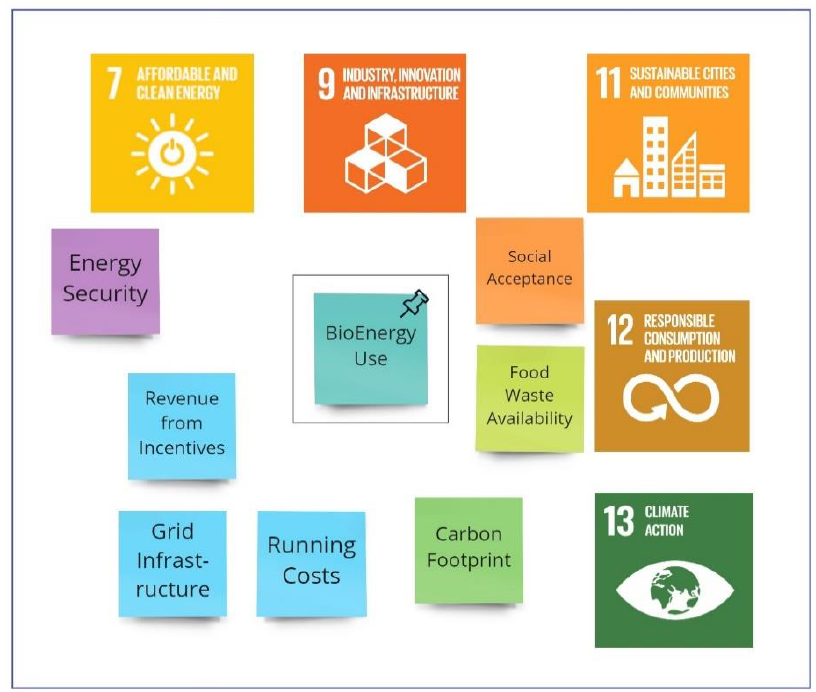
Figure 2. Card sort image for achieving connections with other SIs and the SDGs relating to Bio- energy use from Anaerobic Digestion.